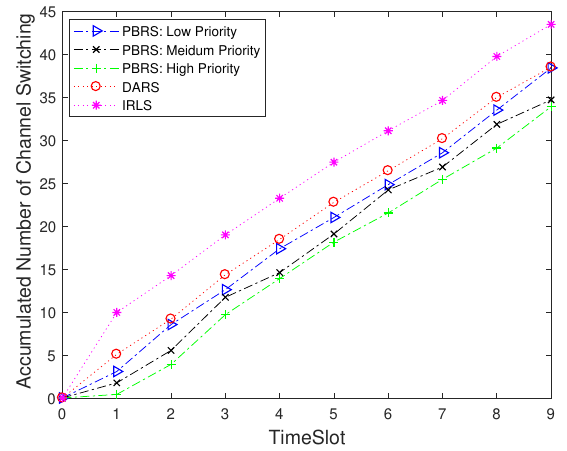
Figure 4. Accumulated average number of channel switching in 10 timeslots